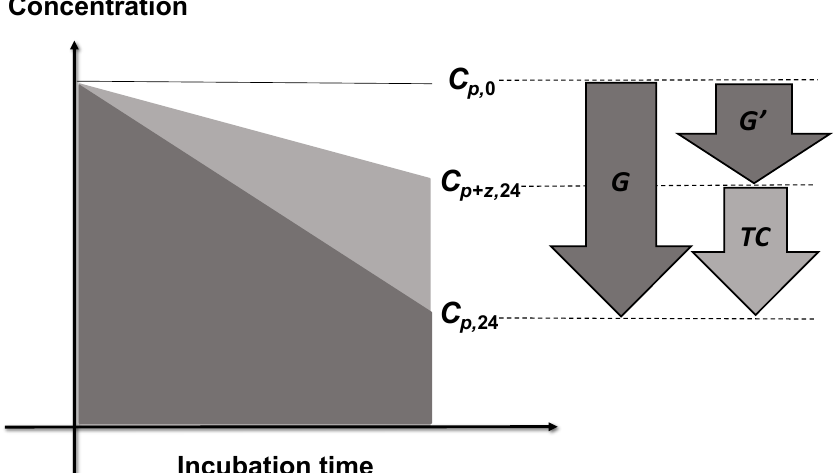
Figure 3. Definition of the intensity of trophic cascades ( TC ). Concentrations of phytoplankton at the beginning of incubation are shown by C p, 0 . Concentrations of phytoplankton in the bottles without and with copepod grazers after 24 h of incubation are C p ,24 and C p+z ,24 , respectively. Copepods ingest protists, thus the grazing from protists on phytoplankton is reduced in the bottles containing copepods. As a consequence, the phytoplankton concentrations in the experimental bottles with copepods and heterotrophic protists are higher than those in the control bottles with only heterotrophic protists. The elimination rate in the experimental bottles ( G’ ) is lower than the elimination rate in the control bottles ( G ) by trophic cascade.